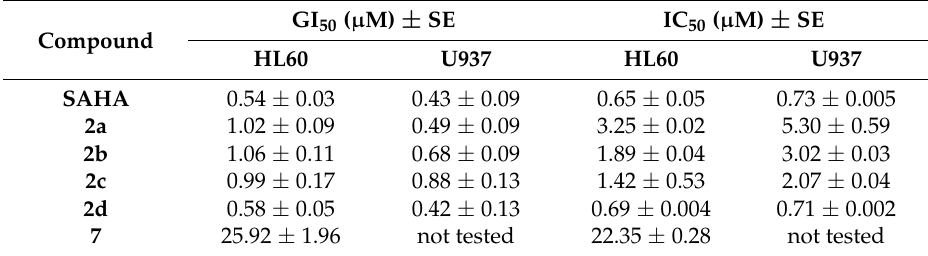
Table 2. Antiproliferative effects of SAHA and the carbamates 2a – 2d and 7 on HL60 and U937 cells (left side, GI 50 ) and their HDAC inhibition in the cellular setting (right side, IC 50 ).